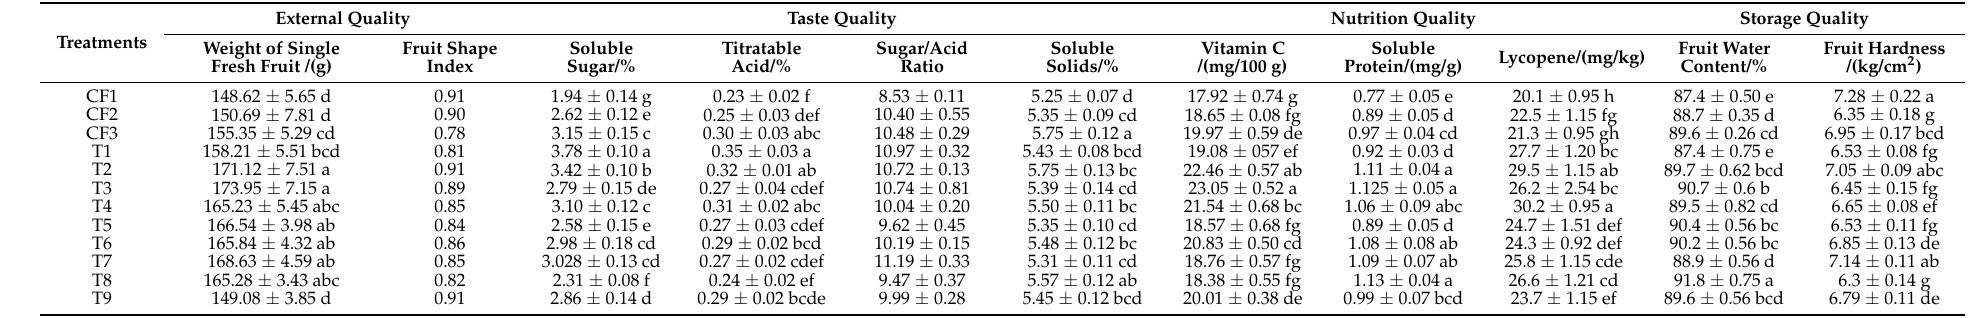
Table 3. Effects of different biogas slurry proportion and irrigation quantity on nutritional quality of